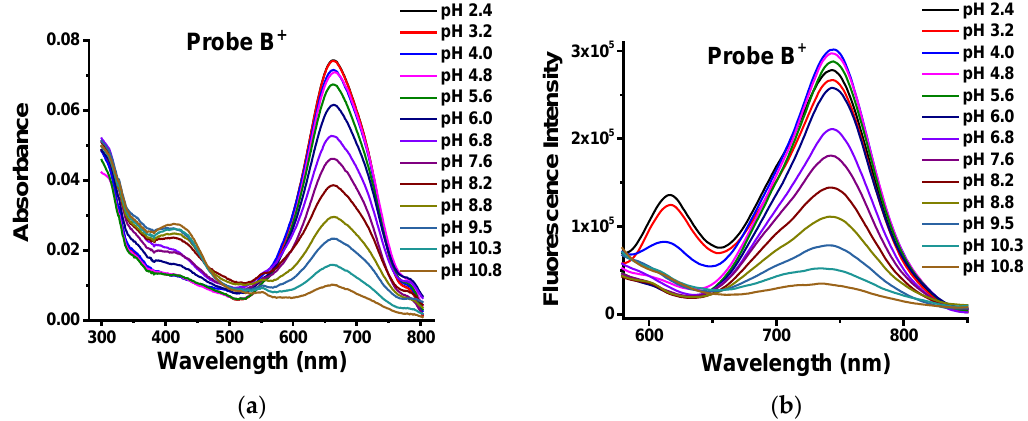
Figure 2. Absorption ( a ) and fluorescence spectra ( b ) of probe B + in different pH buffers under excitation at 450 nm.